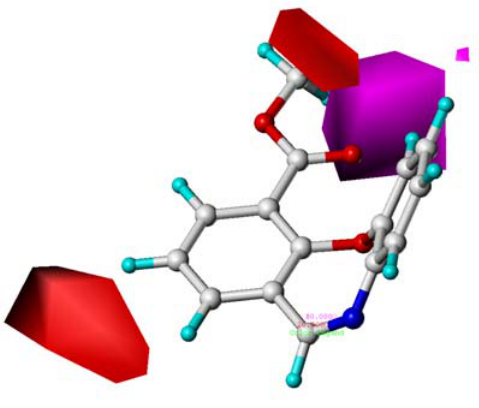
Figure 9. Contour maps of CoMSIA hydrogen bond acceptor region in combination with compound 10 . The magenta and red contours indicate favorable and unfavorable hydrogen bond acceptor groups. Compound 10 is depicted in ball and stick representation, coloured by atom type (white C, blue N, red O, cyan